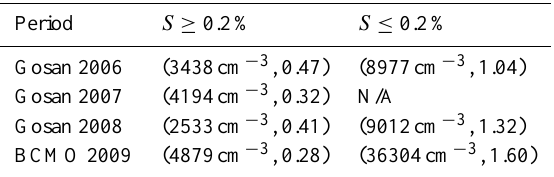
Table 4. Parameters C and k of the CCN spectra power law approx- imations for two S ranges in each